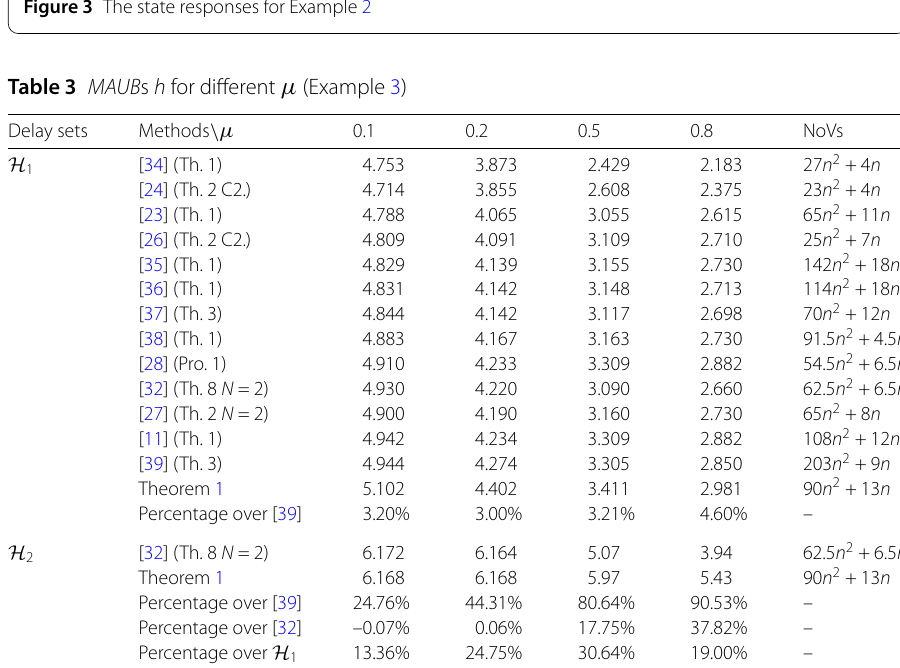
Figure 3 The state responses for Example 2